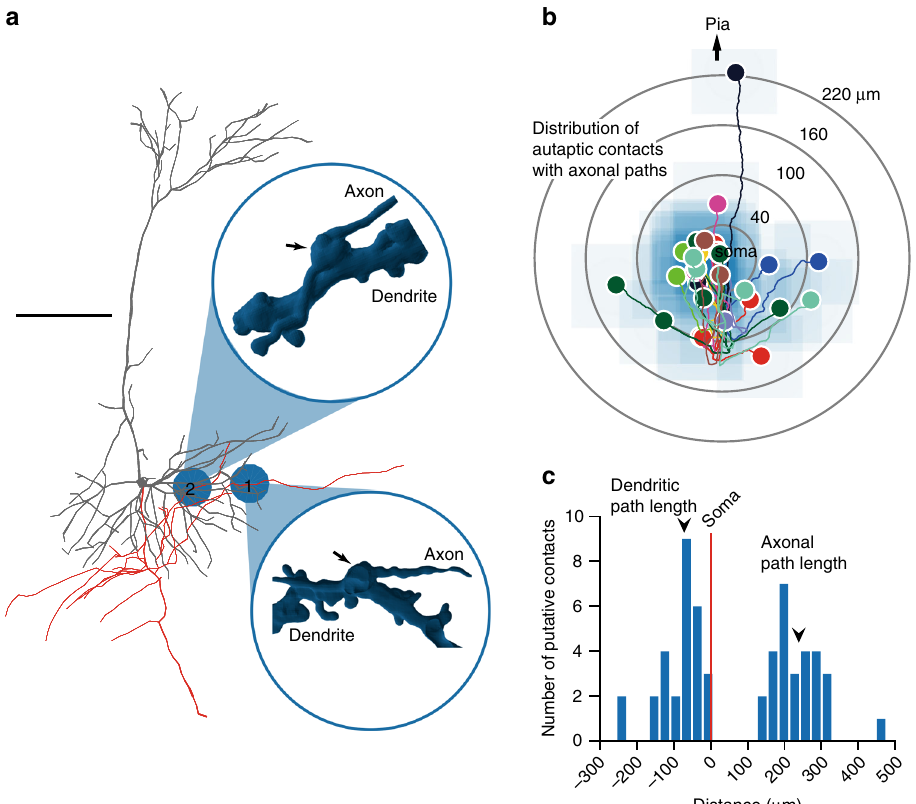
Fig. 4 Autaptic contacts mainly locate at the basal dendrites. a Neurolucida three-dimensional reconstruction of a layer-5 PC. Gray, the soma and dendrites. Red, the axon and its collaterals. Inset, three-dimensional rendering of confocal images showing two putative autaptic contacts between axon and dendritic shaft. Scale bars: 100 μ m. b Group data showing the locations of putative autaptic contacts with axonal paths relative to the soma ( n = 28 contacts, 10 cells). c Distribution of dendritic and axonal path lengths of putative autaptic contacts